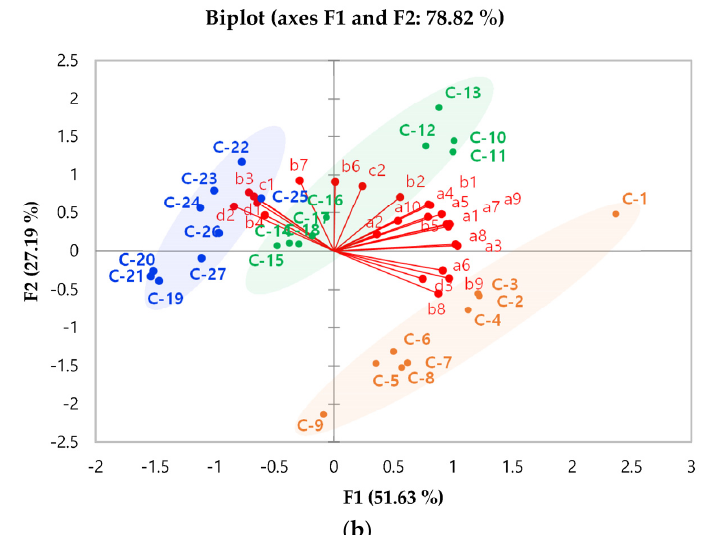
Figure 2. Principal component analysis (PCA) biplot of volatile compounds ( a ) in espresso coffee,